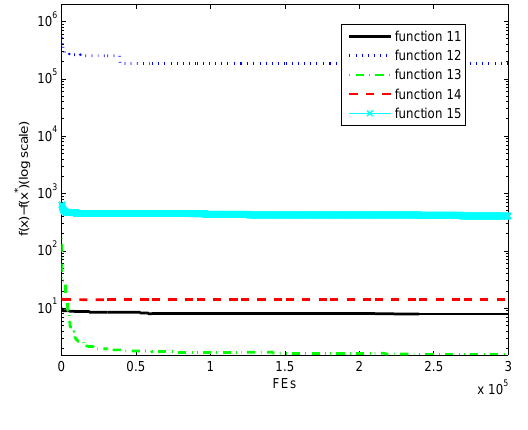
Fig. 3. Convergence Graph for f 11 − f 15 .